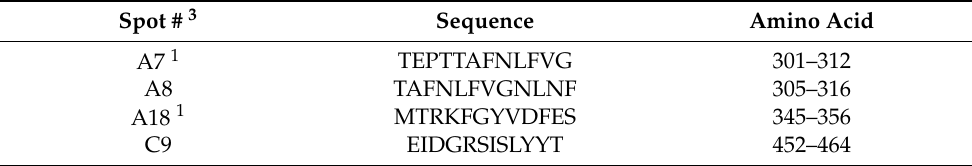
Figure 4. Peptide array of the entire RBD1,2 protein (a.a. 300–466 of human nucleolin) probed with RSV. Spot #A1 is in the top left corner reading from left to right across the array. This experiment was repeated 4 times. Table 1. Table of 12-mer peptides that react well with whole virus probe 2 .